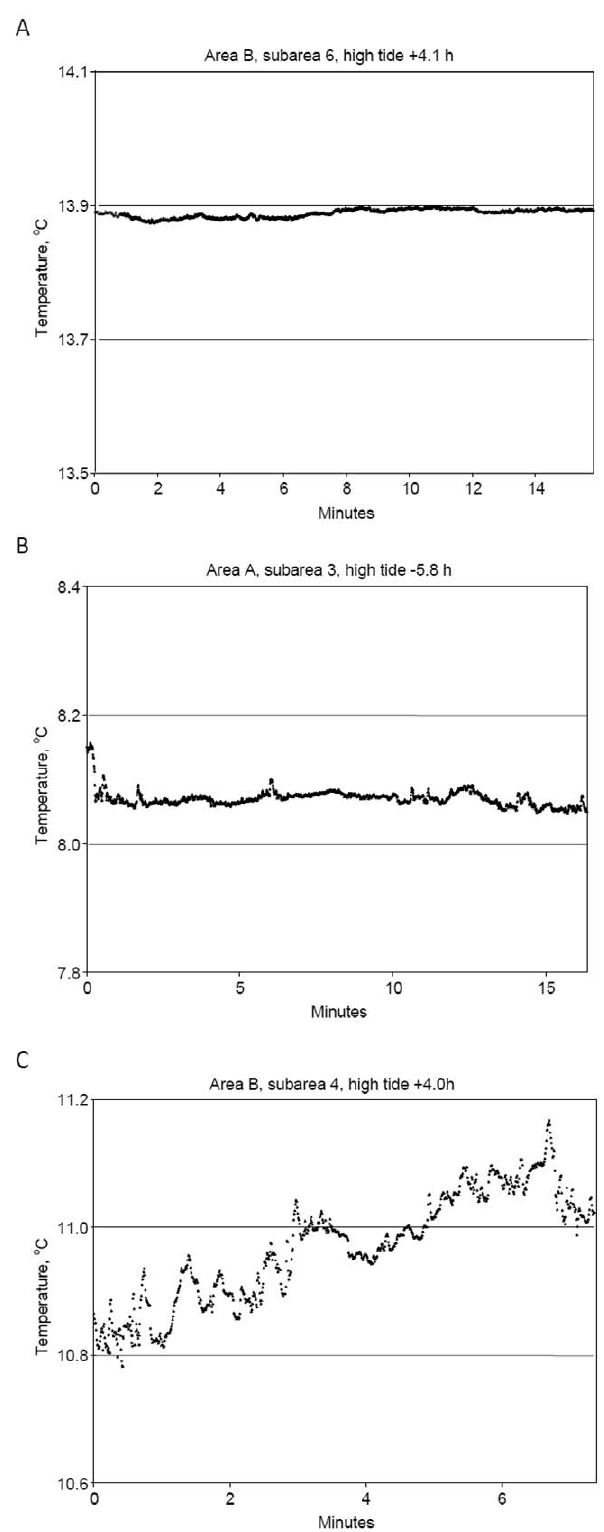
Figure 9. Hydrological complexity in CTD temperature data collected along Seaboss video drift tracks. A. Well-mixed, warm on-bank water showing little overall temperature change ( , 0.1 u C); sta. 908007, 775 m drift. B. Within an hour of low tide in on- and off-bank areas, small high-frequency temperature changes (up to 0.02 u C);